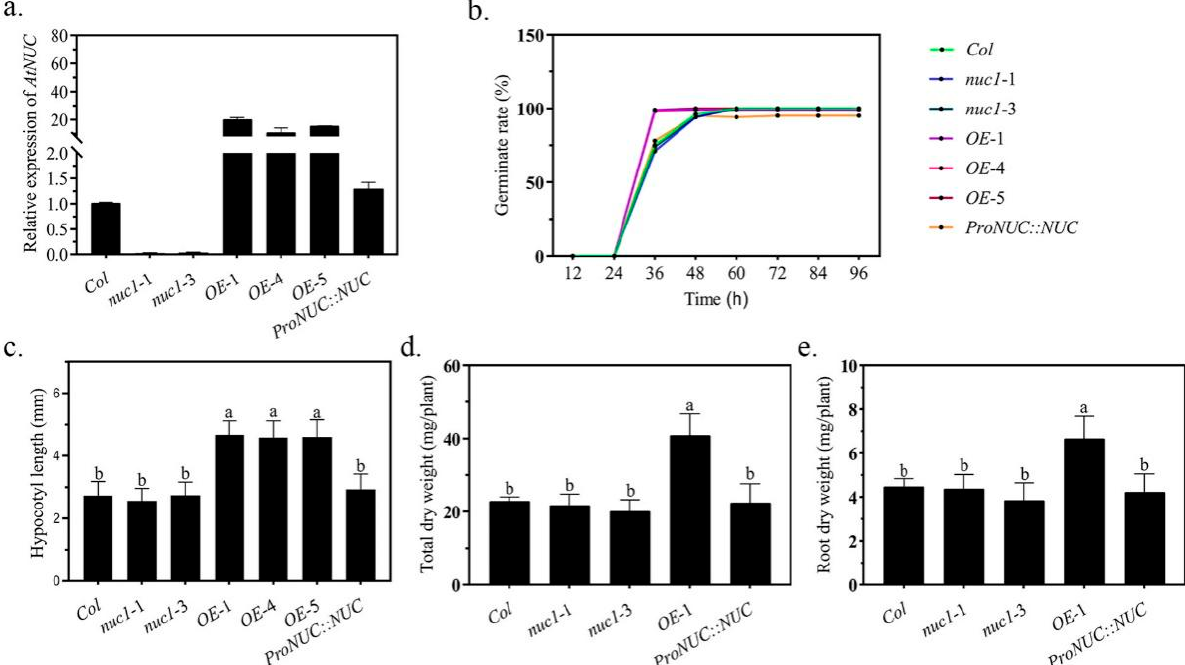
Figure 1. The effects of NUC on the development and growth of Arabidopsis . ( a ): Expression levels of AtNUC were measured by qRT–PCR in different genotype lines. Gene expression in Col was set to 1.0. The Arabidopsis tubulin gene was used as an external reference. Values are the mean ± SDs ( n = 3). ( b ): Germination rate of different genotype lines grown on normal MS medium with a density of 160 plants per plate, 40 seedlings per line. ( c ): Hypocotyl length of 15-day-old seedlings grown on normal 1/2 strength MS medium. Values are the mean ± SDs ( n ≥ 25). ( d , e ): Dry weights of whole plants and hydroponically cultured roots grown for 45 days, respectively. Values are the mean ± SDs ( n ≥ 5). Different letters indicate significant difference between treatments according to Duncan’s multiple range test at p <